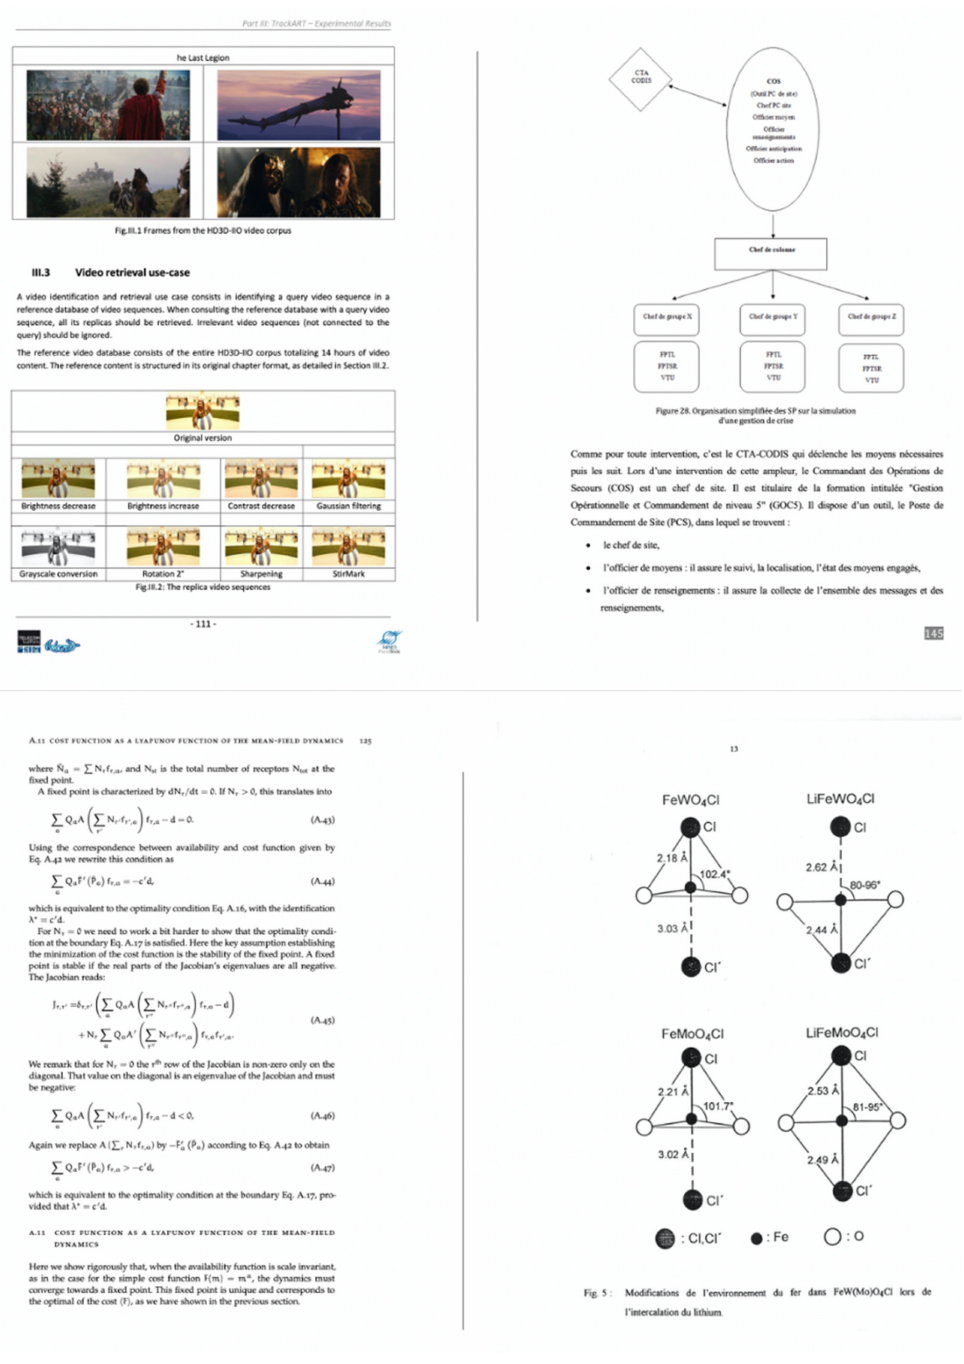
Figure 6. Original images sampled from